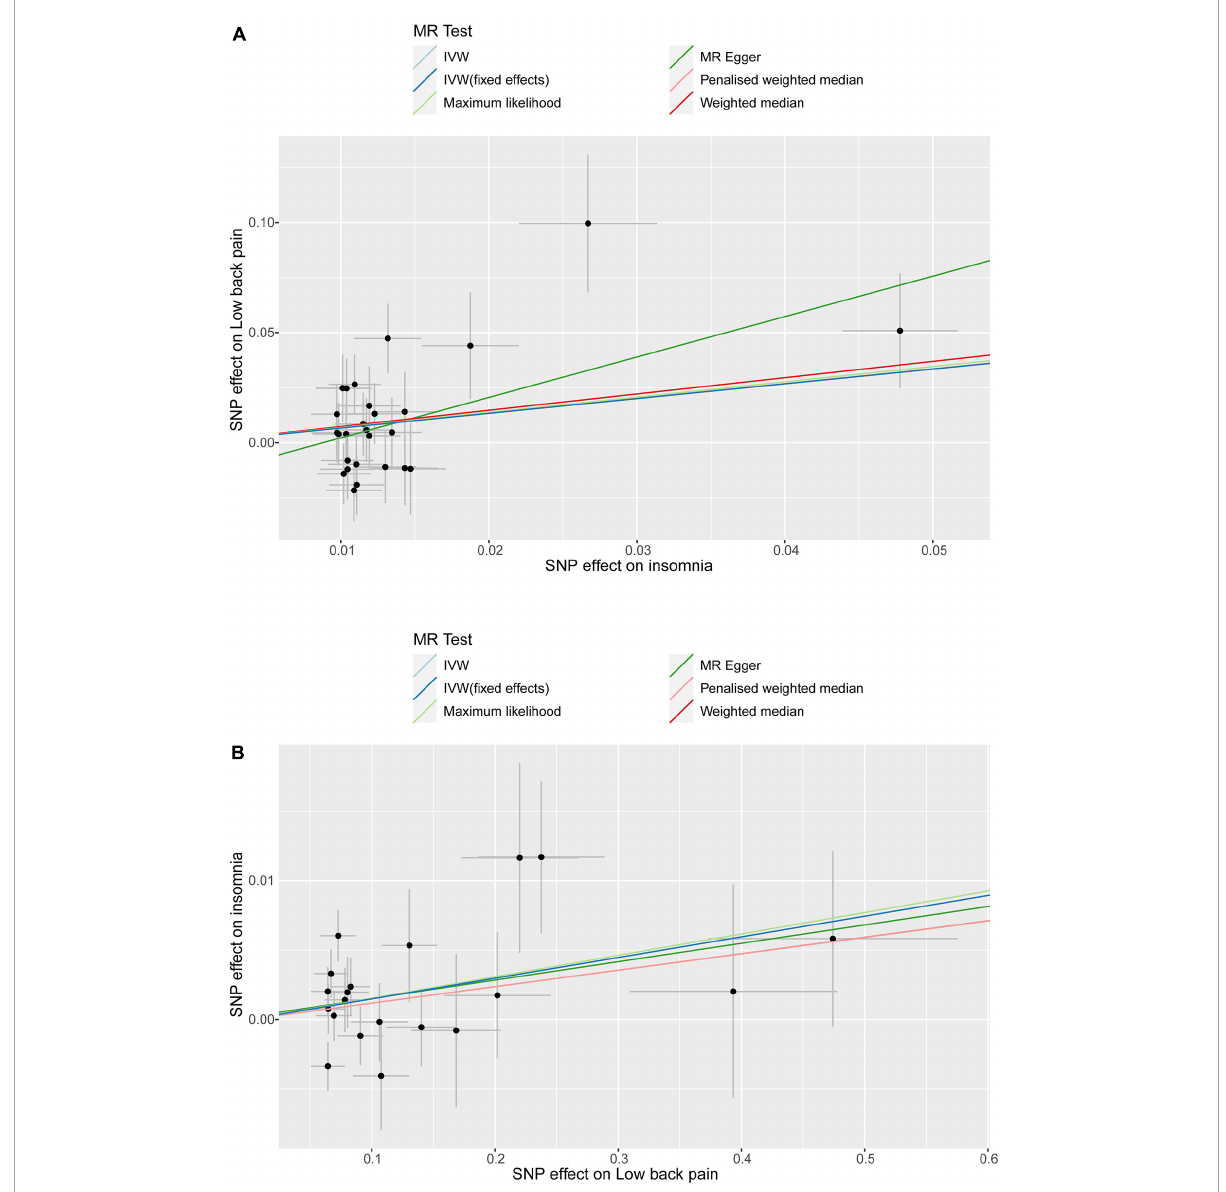
FIGURE1 Individual estimates about the potential causal effect of insomnia and low back pain. The x -axis shows that the single nucleotide polymorphism (SNP) effect on insomnia in (A) and the y -axis shows the SNP effect on low back pain; (B) shows the results of the reverse causal inference. Several methods of MR analysis including MR Egger, weighted median, inverse variance weighted (IVW), maximum likelihood(ML) and penalized weighted median were